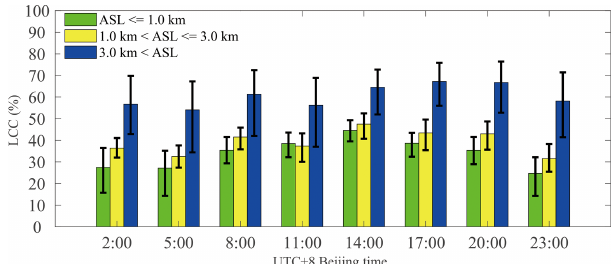
Figure 3. The diurnal cycle of LCC in summer from 2010 to 2019 at different altitudes above sea level (ASL): ASL ≤ 1.0km (LCC L ), 1.0km < ASL ≤ 3.0km (LCC M ), and 3.0km < ASL (LCC H ). It should be noted that all the sites ranged from 27 to 40 ◦ N in China, and each sample is derived from the monthly mean LCC at a partic- ular time in summer for each site. The bar and error bar represent the median values and interquartile ranges (IQRs) of LCC, respec- tively. The subscripts L, M, and H of LCC denote the low, medium, and high clouds,